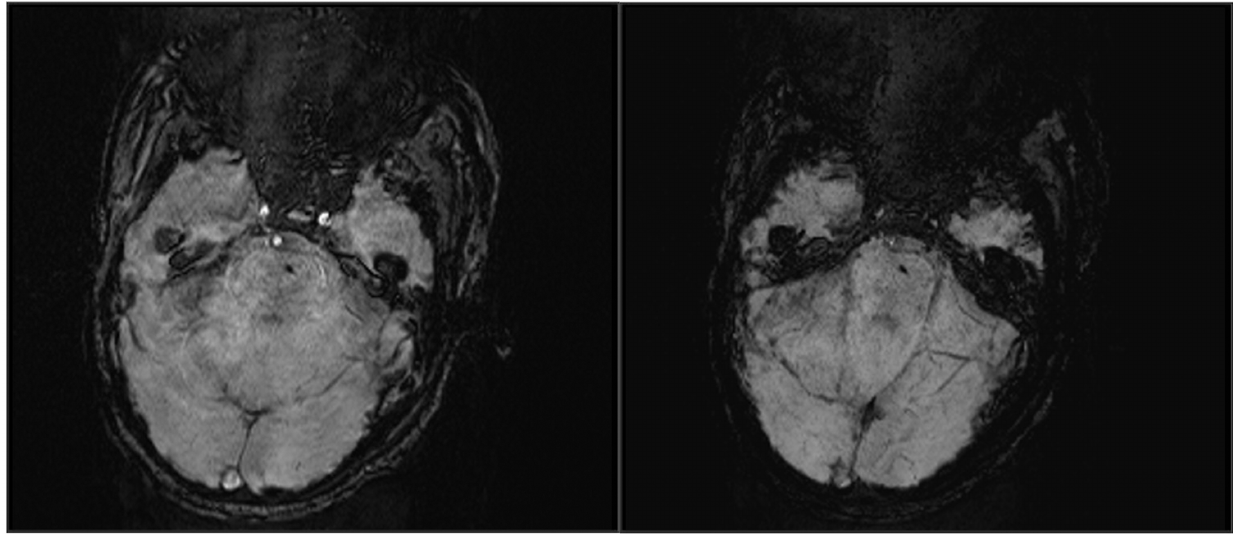
Figure 1. SWI obtained in a 64-year-old woman after heat stroke with a score of 3 in Glasgow Coma Scale. On the 5th day after admission, amplitude (A) and minIP (B) images show punctate hemorrhage detected in brain stem. doi:10.1371/journal.pone.0105247.g001 PLOS ONE |